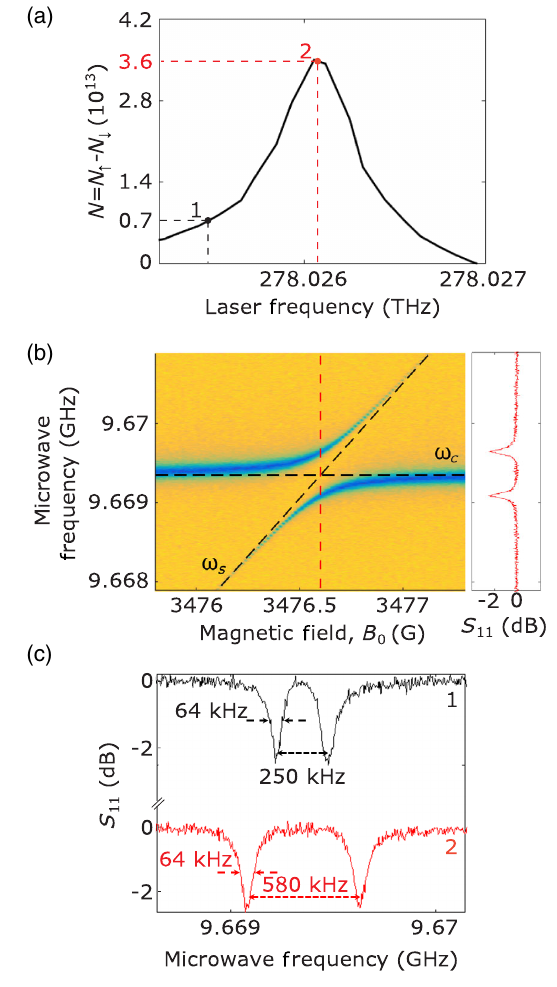
ffiffiffiffi p ¼ 56 kHz, N